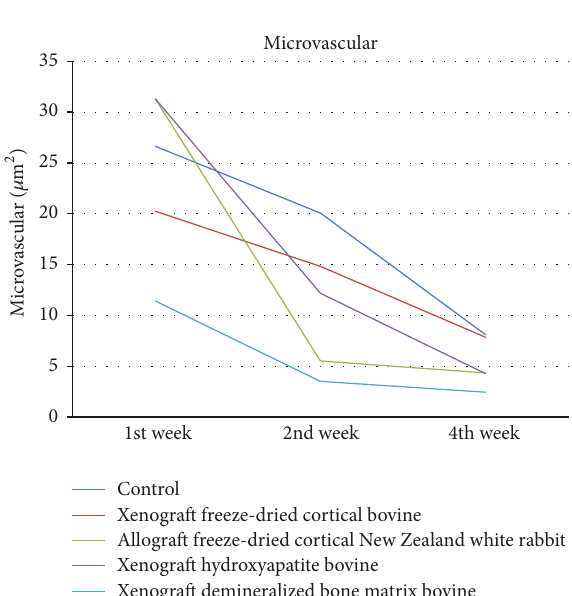
Figure 2: Evaluation of VEGF/ 𝜇 m 2 .